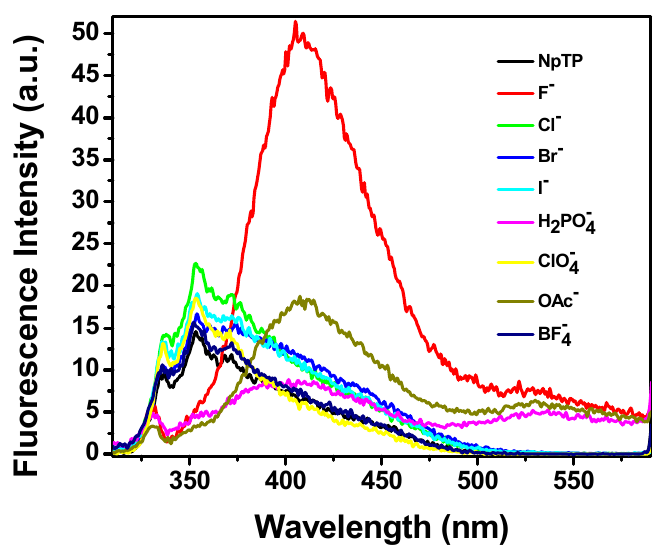
Figure 9. Fluorescence spectra of NpTP (~1 × 10 − 6 M) upon the addition of 4 × 10 − 4 M of various anions in acetonitrile. λ exc = 300 nm.